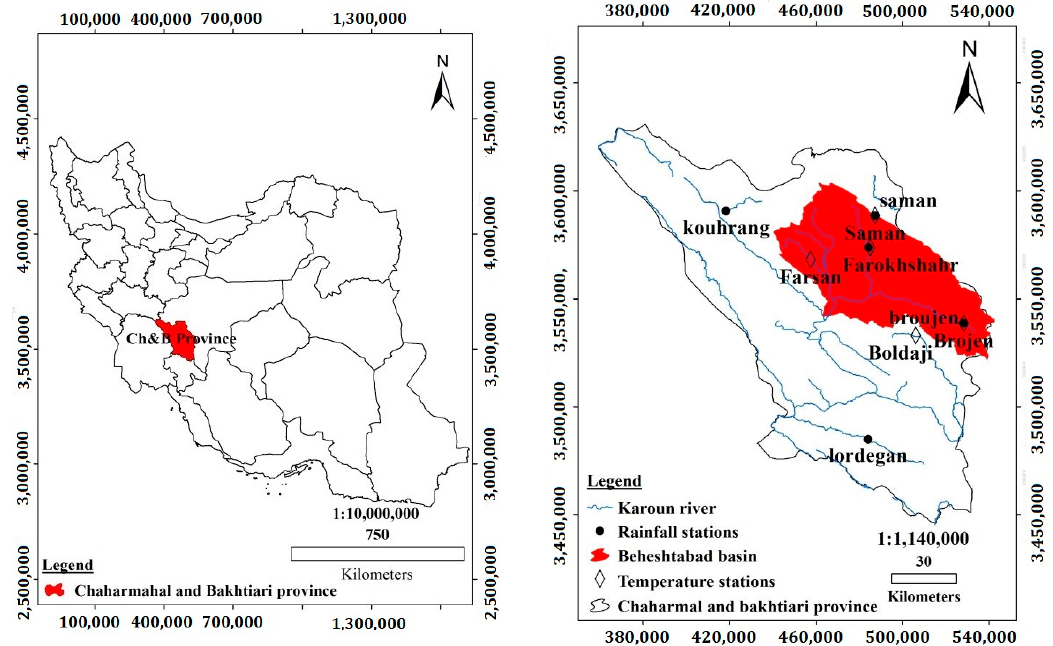
Figure 1. Left : Iran with the Chaharmahal and Bakhtiari province; Right : Behesht-Abad Basin boundary and the location of rainfall and temperature stations.